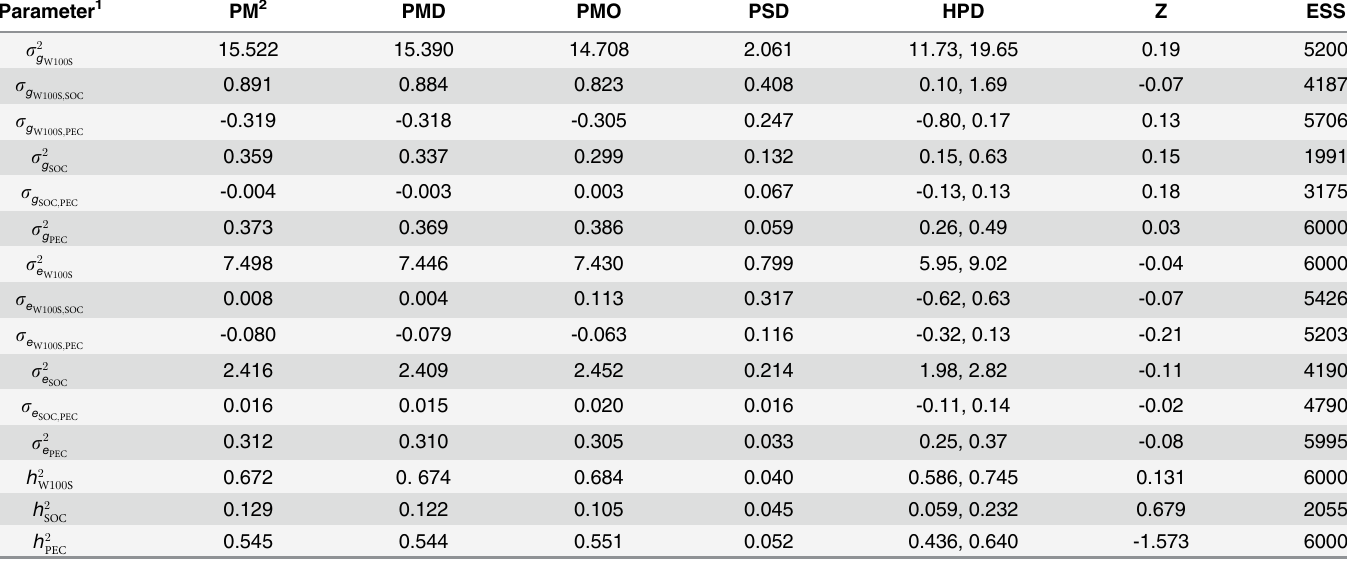
Table 1. Variance components and genetic parameters estimated under the Bayesian multi-trait analysis via Gibbs sampling of weight of 100 seeds (W100S), seed oil content (SOC) and phorbol ester concentration (PEC) traits. Parameter 1